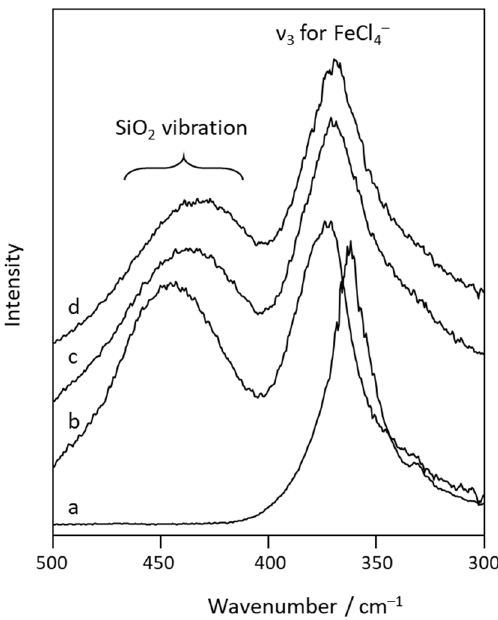
Figure 8. Far-IR spectra of ( a ) unconfined [C 2 mim]FeCl 4 and [C 2 mim]FeCl 4 confined within ( b ) 8.36, ( c ) 7.36, and ( d ) 5.39 nm mesoporous silica. ( c ) 7.36, and ( d ) 5.39 nm mesoporous